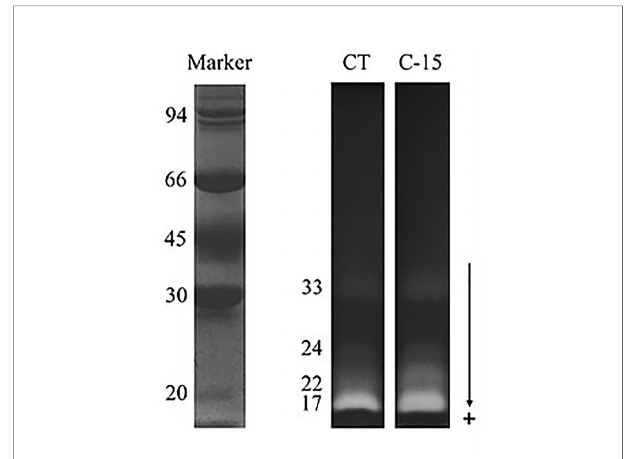
FIGURE 1 | Zymogram showing total proteolytic activity from pooled intestinal extracts of fi sh. Dietary codes: CT, control diet; C-15, 15% C. fusca supplemented-diet. Protein standards employed were phosphorylase b (94), bovine serum albumin (66), ovalbumin (45), carbonic anhydrase (30), soybean trypsin inhibitor (20). The molecular mass (in kDa) of proteins was measured using a linear plot of log Mr. of protein standards (M) vs. relative mobility (Rf). Five microliters of molecular weight marker (M) were